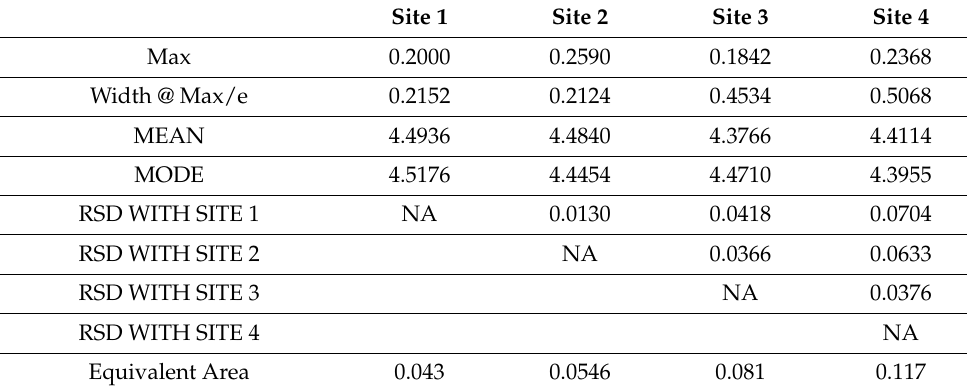
Table 3. Quality of the mean frequency as a classifier.